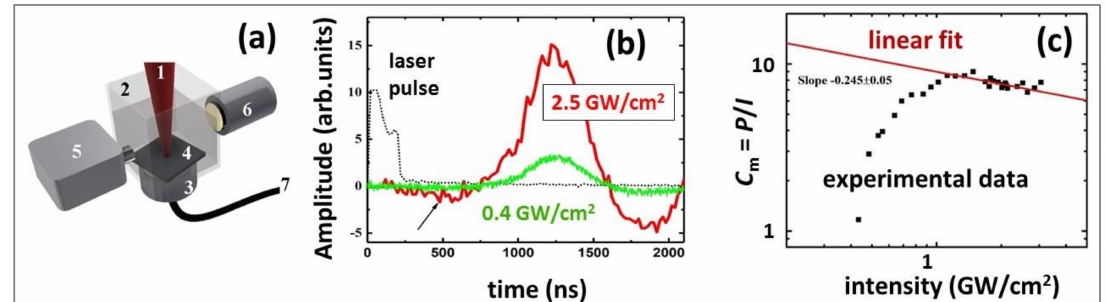
Figure 2. ( a ) Experimental arrangement for ultrasonic characterization: (1) focused fiber ns-laser beam, (2) cuvette filled with liquid (distilled water, thickness of water layer under target ~2 mm), (3) ultrasonic transducer (bandwidth ~30 MHz), (4) silicon wafer, (5) UV-VIS-spectrometer (OceanOptics), (6) light source, (7) to oscilloscope (Tektronix TDS3054C); ( b ) ultrasonic transients at different laser intensities (laser pulse is shown for the reference); ( c ) mechanical coupling efficiency C m versus laser intensity, showing the initial low-intensity range of the threshold-like phase explosion pressure and the succeeding high-intensity range of sub-critical plasma pressure with its linear fit in the double logarithmic